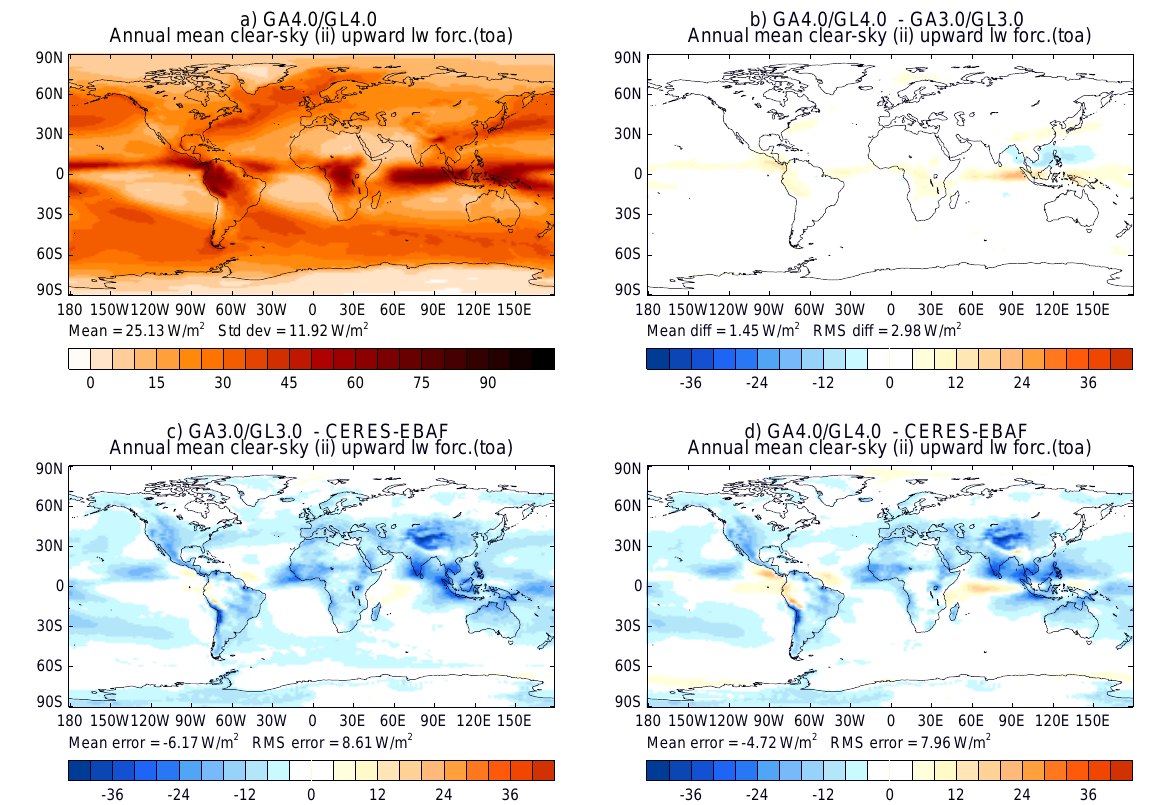
Fig. 12. Annual mean longwave cloud forcing from N96-AL_clim using the same format as Fig. 7. The validating data set is from the CERES-EBAF climatology (Loeb et al., 2009).